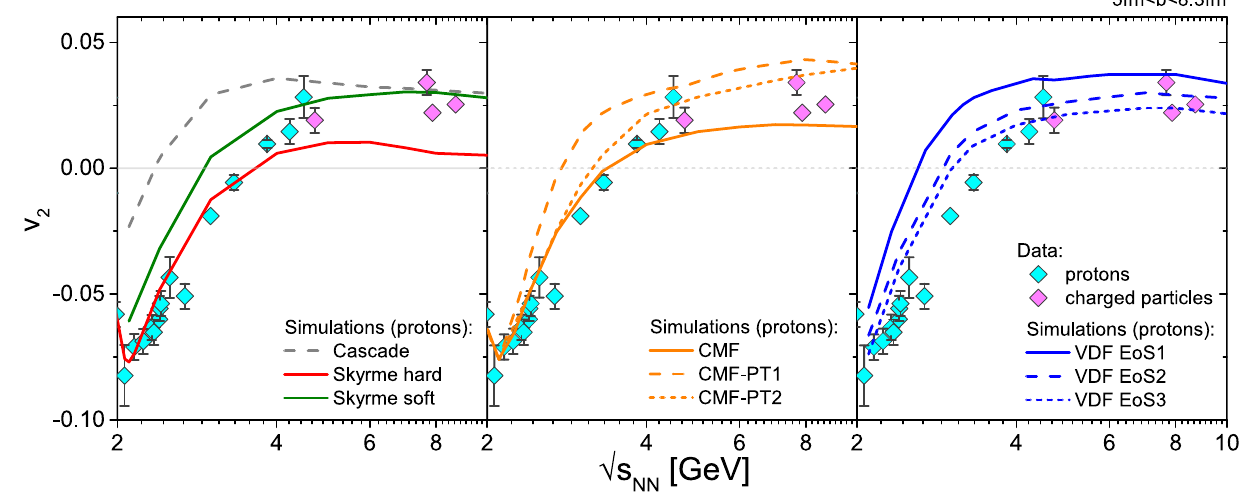
Fig. 4 The elliptic flow of protons, with respect to the reaction plane, for mid-central Au–Au collisions (5 < b < 8 . 3 fm). The elliptic flow is evaluated at mid-rapidity | y / y b | < 0 . 1 ( y is the proton rapidity in the center of mass frame of the collision, i.e. y cm = 0, and y b is the beam rapidity defined in the center-of-mass frame of the collision) and